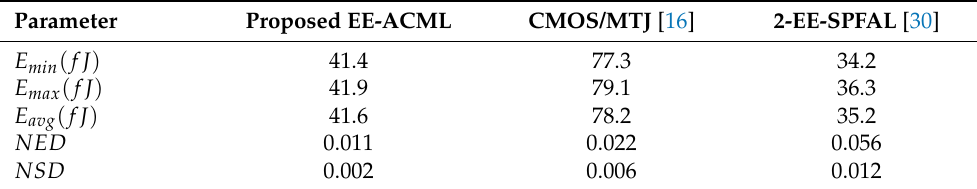
Table 5. Normalized Energy Deviation and Normalized Standard Deviation values for EE-ACML- based